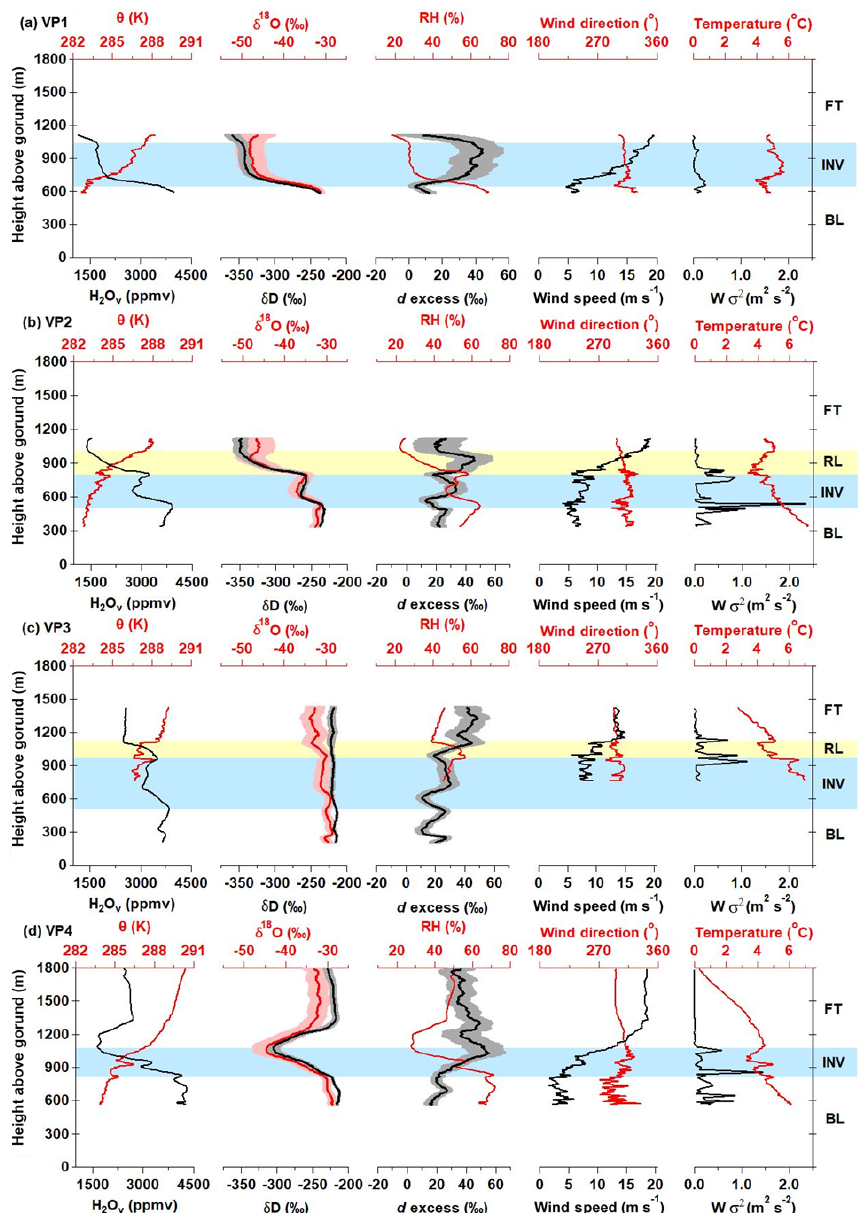
Figure 11. DBL vertical profile (VP) measurements from 18 March 2016 in the boundary layer (BL), inversion layer (INV; blue), previous day’s residual layer (RL; yellow), and free troposphere (FT). Observations corresponding to VP1–VP4 are shown in (a) – (d) ,